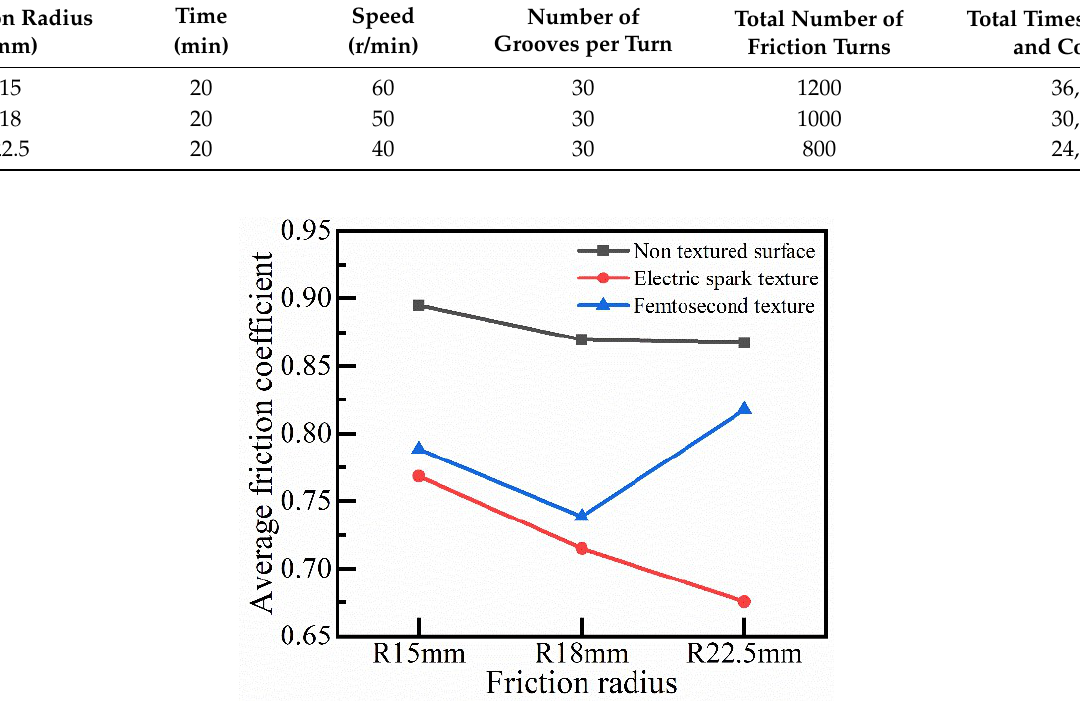
Figure 6. Average friction coefficient of different samples.